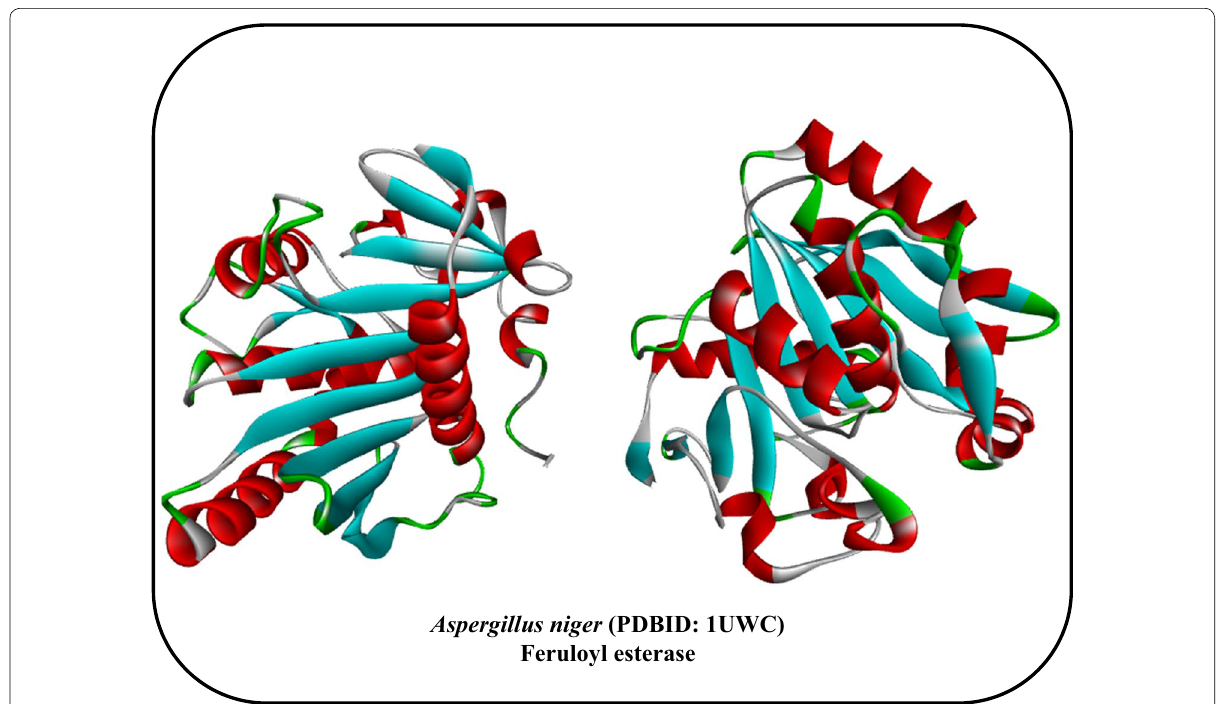
Fig. 5 The protein secondary structure of Aspergillus niger feruloyl esterase (carbohydrate esterase class-I) (PDB ID:1UWC) (McAuley et al. 2004), where alpha-helices (red), beta strands (blue) and coils (gray). (Image was developed using Discovery Studio Visualizer ®